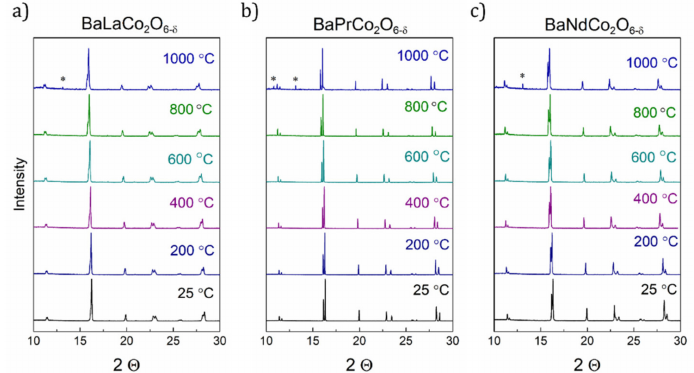
Figure 2. High-temperature Synchrotron Radiation Powder X-ray Di ff raction (SR-PXD) di ff ractograms of BLC ( a ), BPC ( b ), and BNC ( c ). * denotes reflections from a reaction product between the sample and the silica